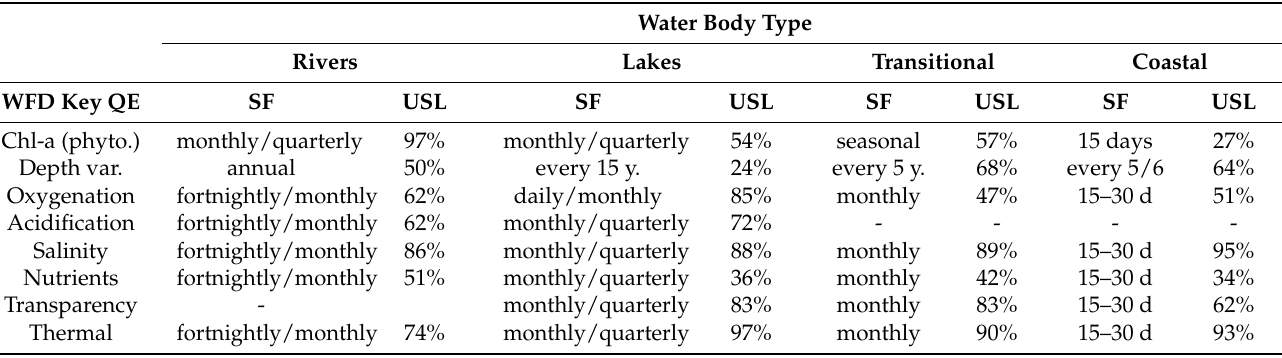
Table 1. The percentage of water bodies (per type) with unknown status level for WFD mandatory QEs and their monitoring frequencies (SF means sampling frequency while USL is the Unknown Status Level in